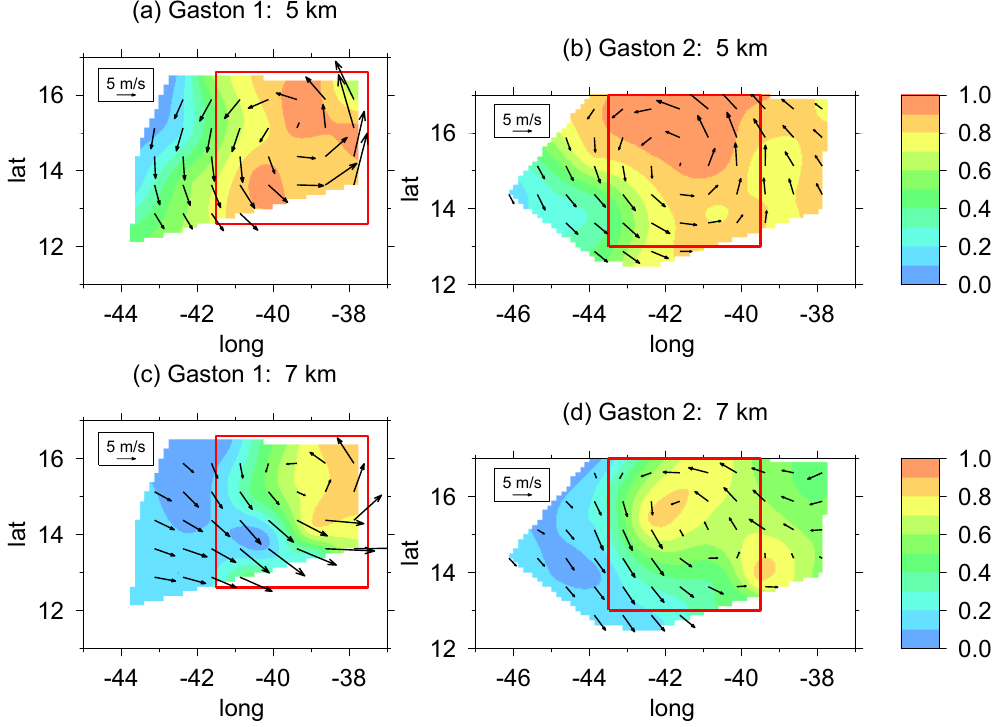
Fig. 5. Relative humidity during Gaston 1 (left panels) and Gaston 2 (right panels) at 5 km and at 7 km. The vectors represent the relative wind at the respective levels. The red boxes enclose the area selected for analysis.